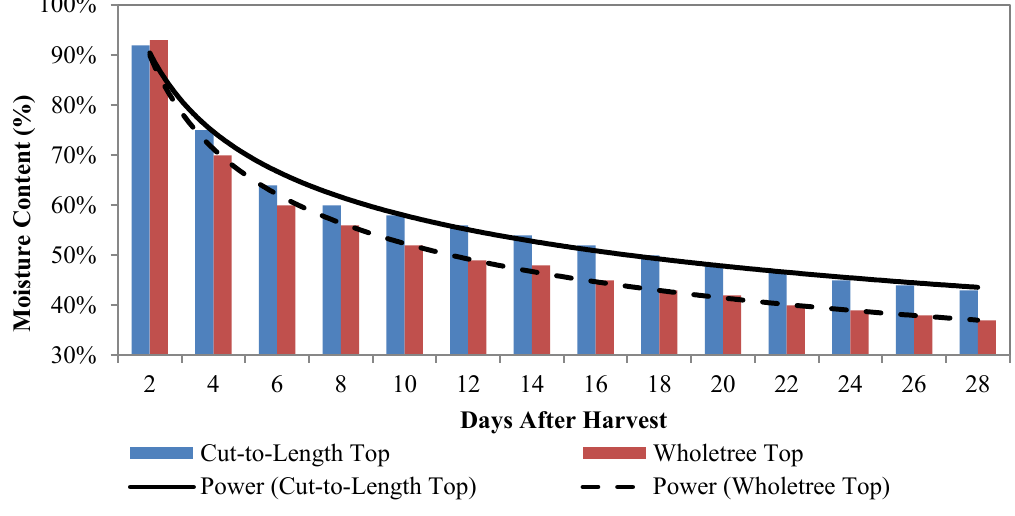
Figure 3. The mean moisture content of stem wood separated by treatment type and stem location in the time following harvesting; Treatment 1 represented a cut-to-length harvesting system and Treatment 2 a whole-tree system; these results show the MC in the upper portions of the stems.